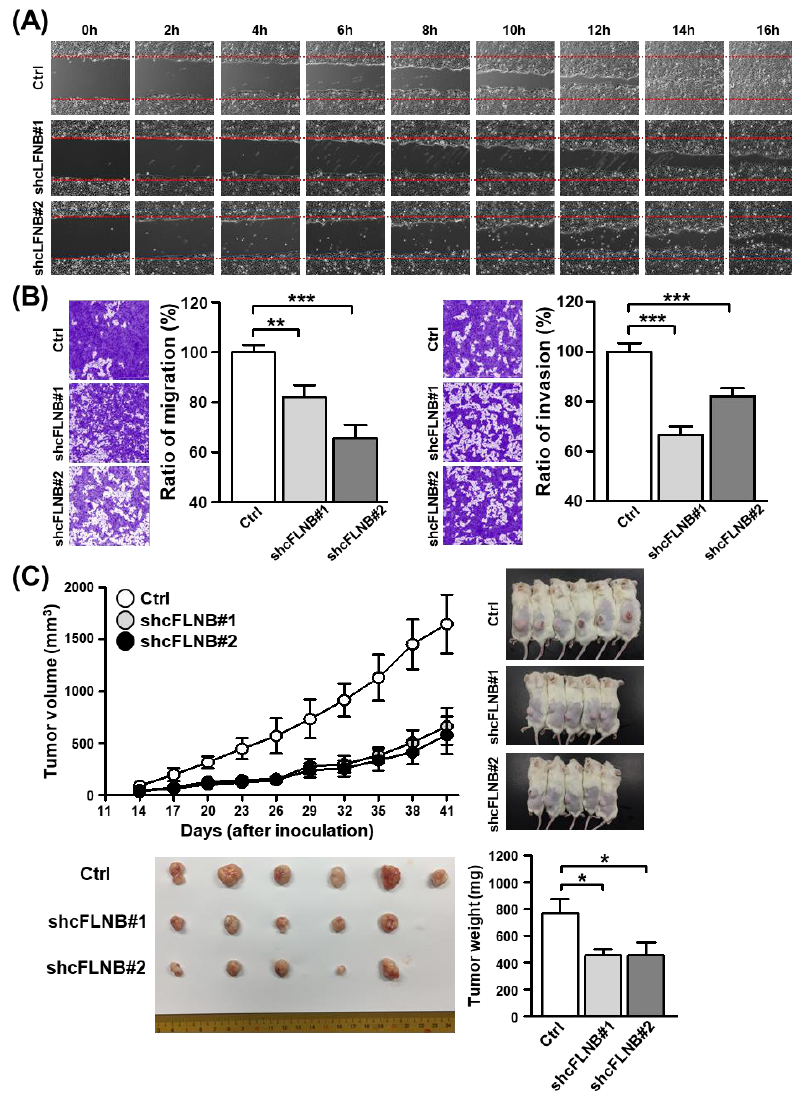
Figure 6. The circFLNB modulates migratory and invasive capability in OSCC. ( A ) The wound healing migration assay was performed to assess the migratory ability of SAS cells upon circFLNB knockdown. Photographs were taken at the indicated time points after cells were scratched, with representative images shown. ( B ) Transwell migration (left) and Matrigel invasion (right) assays were carried out after knockdown of circFLNB in SAS cells. The representative photomicrographs are shown. Average migratory area per field was quantified and expressed as a percentage relative to control cells (Ctrl). ( C ) The mouse xenograft experiment was performed by inoculating control and circFLNB knockdown SAS cells. Tumors formed at the indicated time points were dissected and measured for the volume (upper left). The right panel shows photographs of mice bearing tumors (top right) and the surgically removed tumors (bottom left). The bar graph depicts average weights ( n = 10 or 11) of the tumor masses dissected from the indicated groups at sacrifice (day 41). For statistical analyses shown in this figure: * p < 0.05; ** p < 0.01; *** p < 0.001.